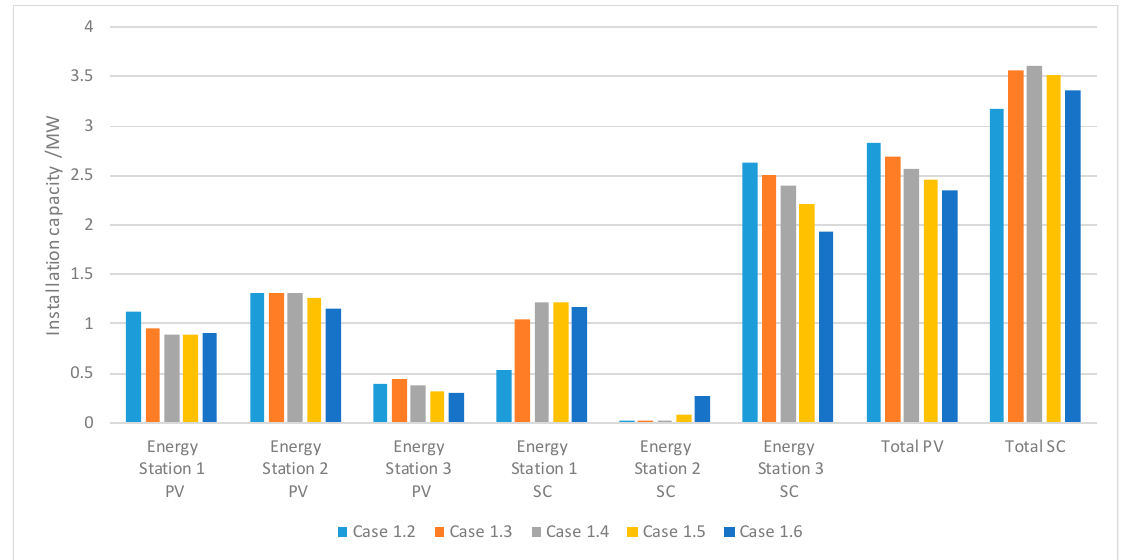
Figure 3. Accommodation capacity comparison of Cases 1.2 to 1.6.